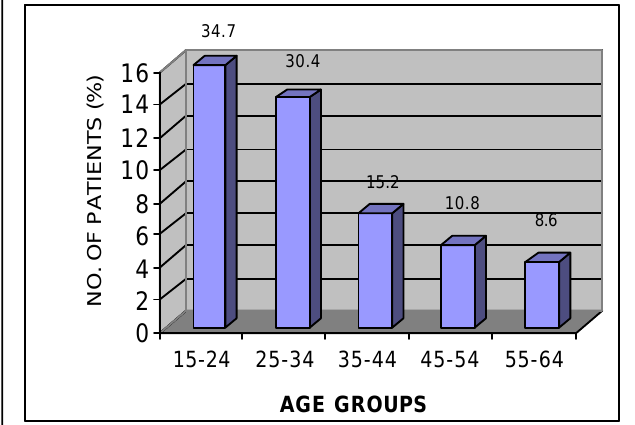
Fig. 1 : Age distribution of patients (n=46)